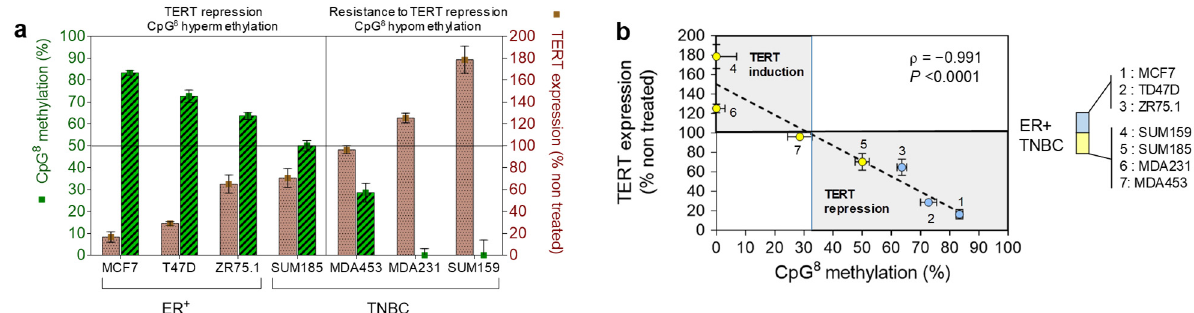
Figure 6. Histograms ( a ), scatter plots, and linear regression line ( b ) for hTERT expression induced by ATRA treatment vs. methylation of the CpG located in region II at chr5: 1,300,438 (CpG 8 ). The dashed line indicates the fitted line from the linear regression model. The vertical blue line indicates the threshold methylation level above which ATRA-induced TERT repression may be expected. Blue and yellow dots represent the ER + and TNBC cell lines, respectively.